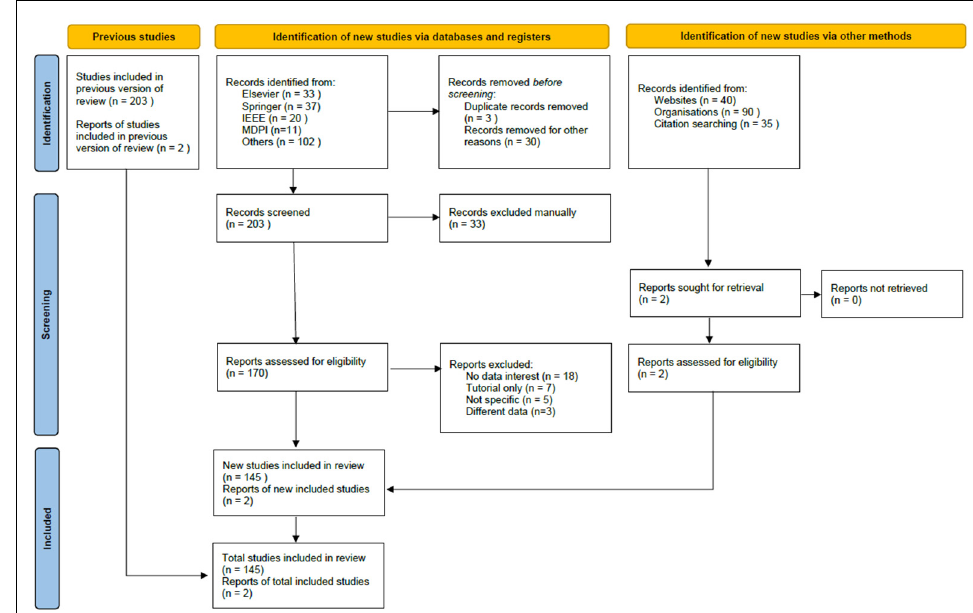
Figure 2. PRISMA flow chart.